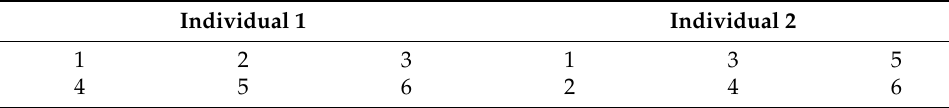
Table 6. Example